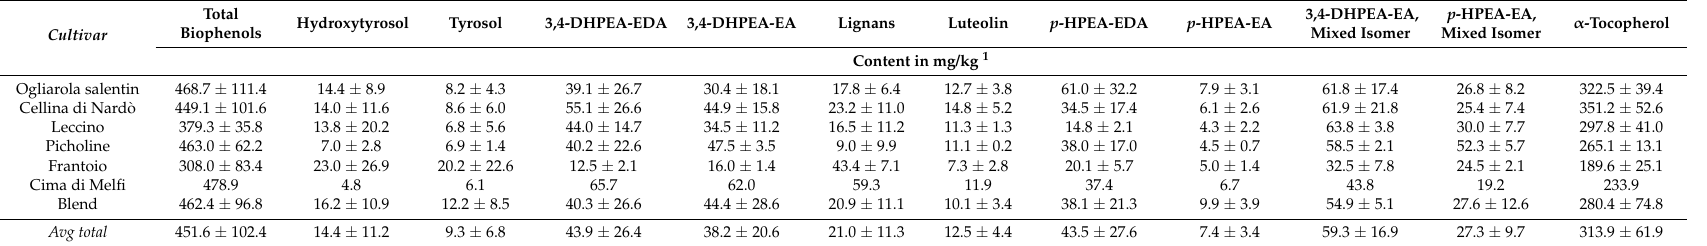
Table 2. Content of phenols in EVOO samples organized by type of cultivar .